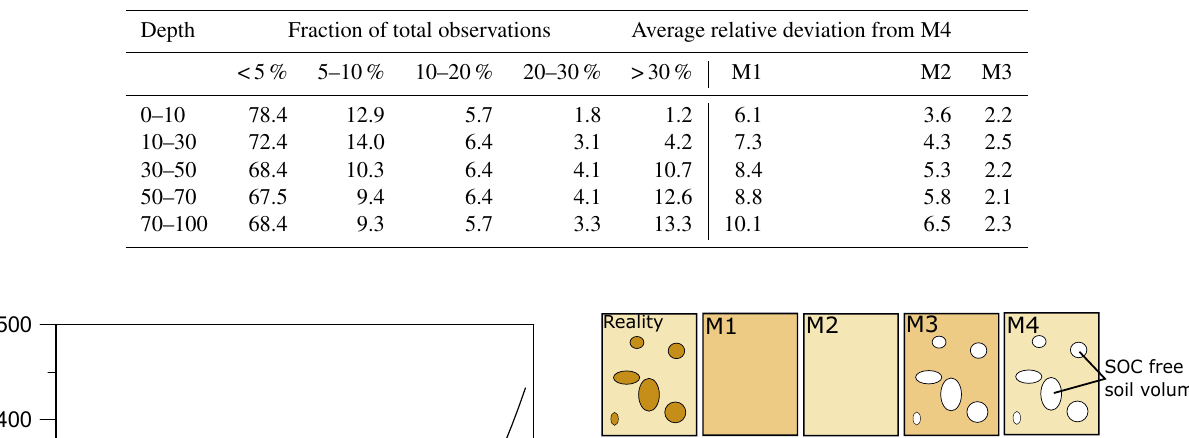
Table 1. Fraction of total observations for different volumetric rock fragment content classes in the German Agricultural Soil Inventory and average soil organic carbon stock deviations (%) from M4 for the calculation methods M1–M3 in different depth increments.